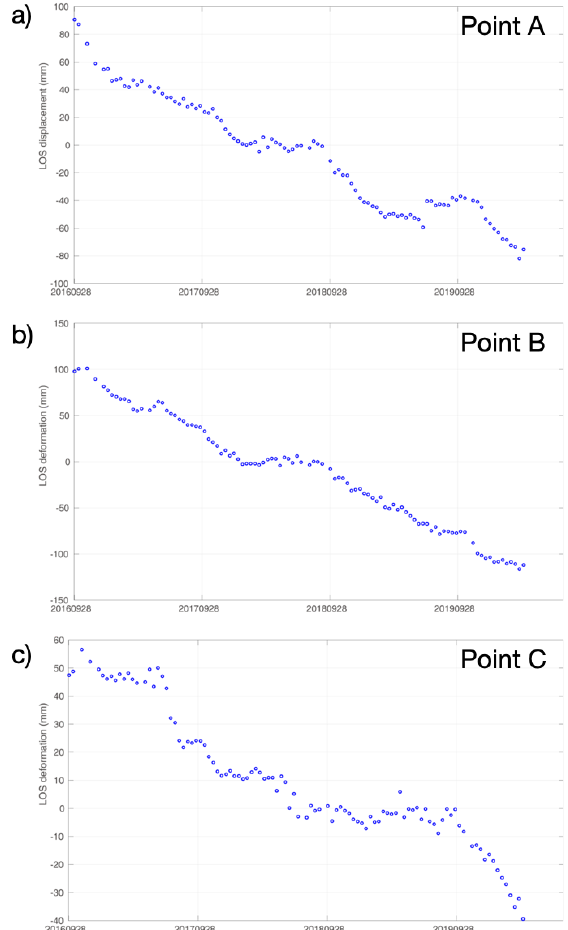
Figure 3. Time series displacement curves for point A, B and C